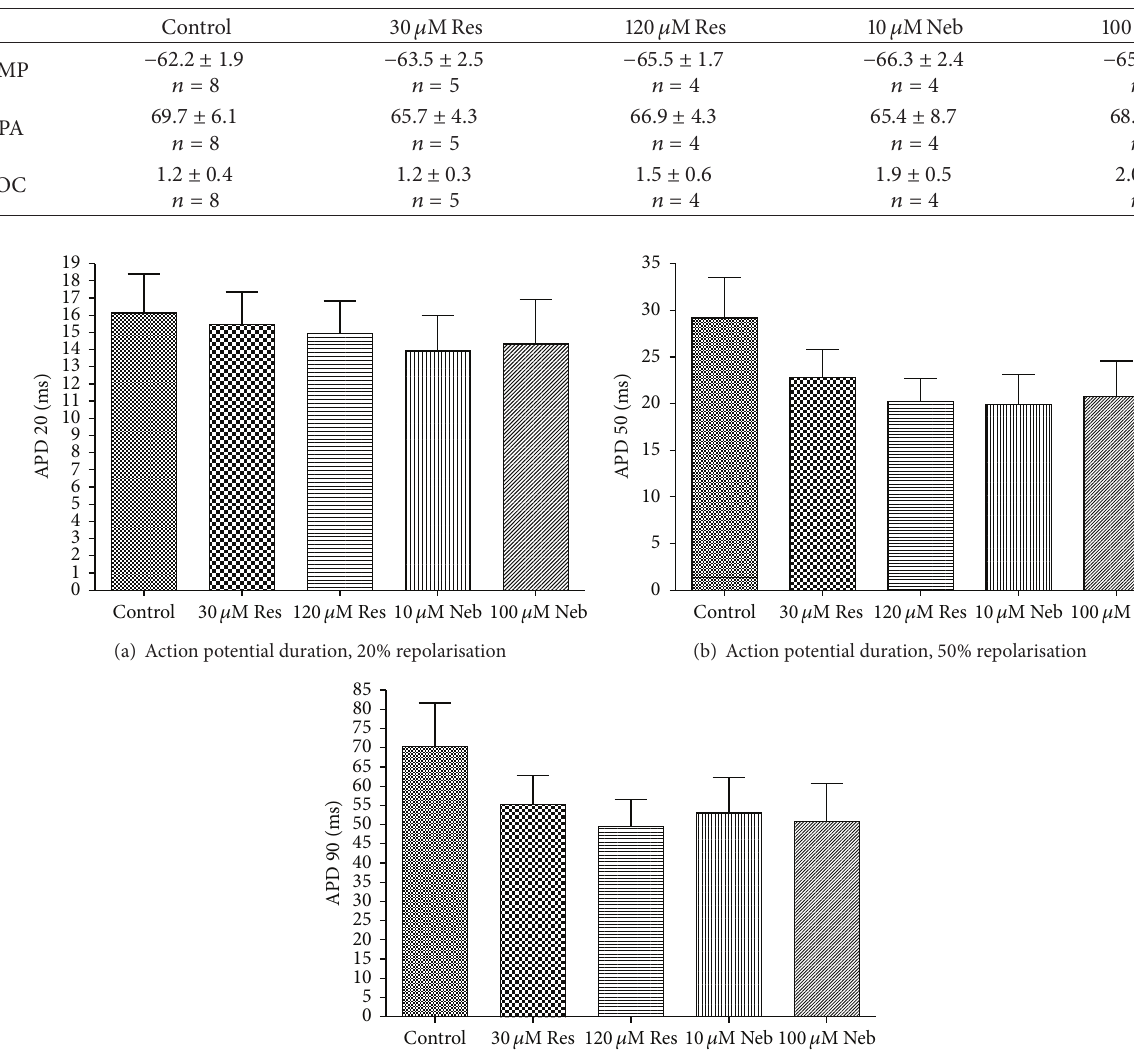
Table 1: Effect of resveratrol and nebivolol on resting membrane potential (RMP), action potential amplitude (APA) and force of contraction (FOC) in isolated papillary muscle cells.